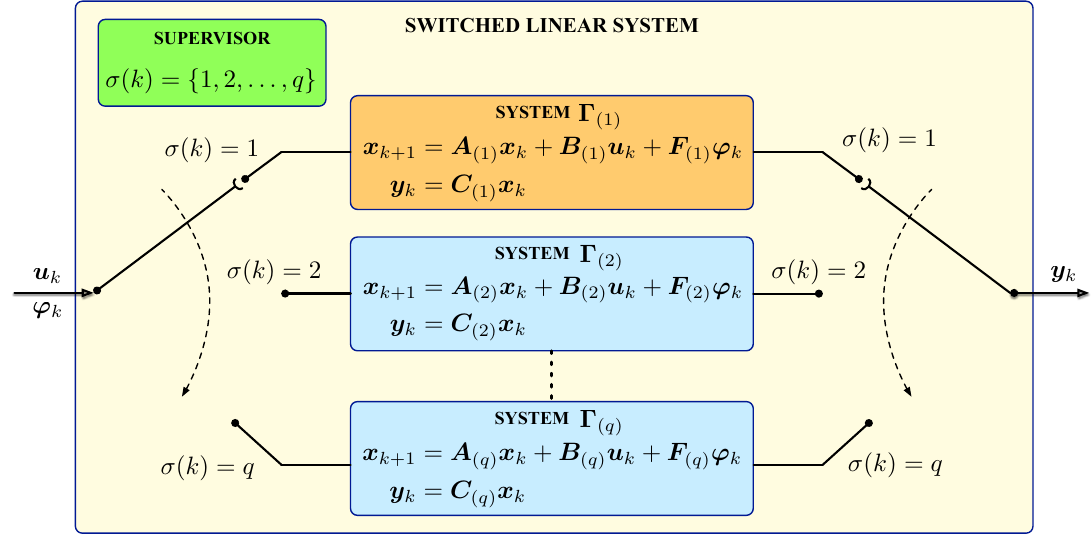
Figure 3. Switched linear system